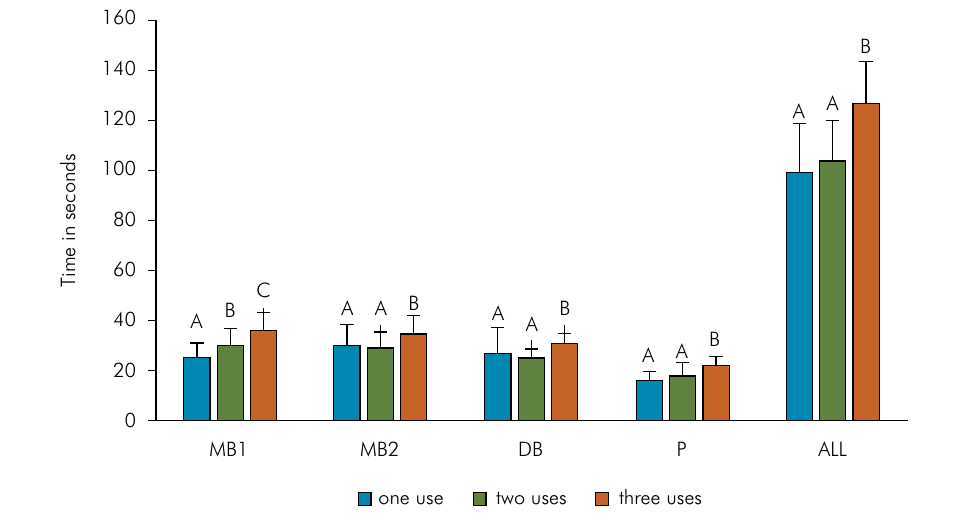
Figure 1. Time required preparing each root canal and the total tooth (used once, twice or three times). MB- Mesiobuccal canal, MB2 – Second mesiobuccal, DB – Distobuccal canal, and P – Palatal